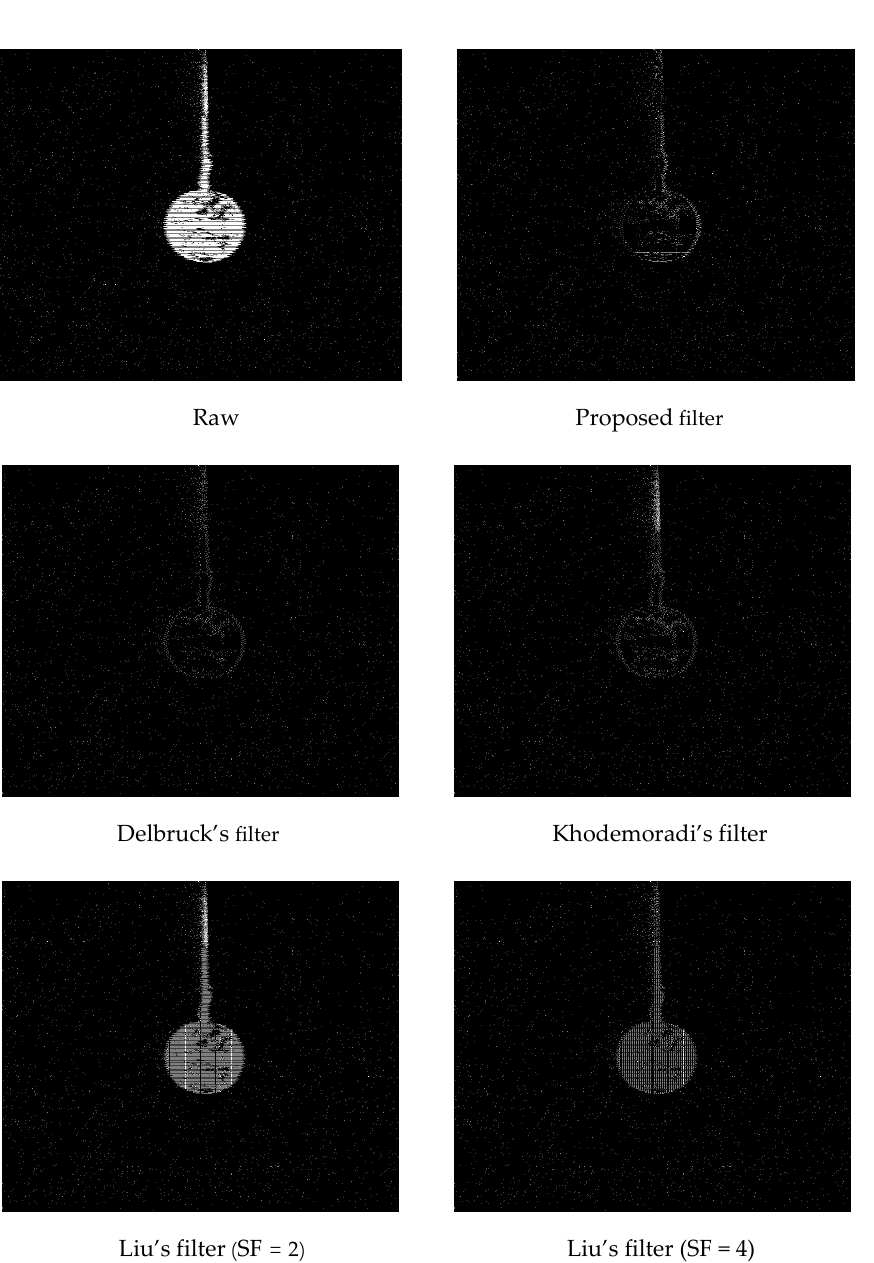
Figure 11. Binary images of the raw image and the events filtered by the five filters at 3923 ms .